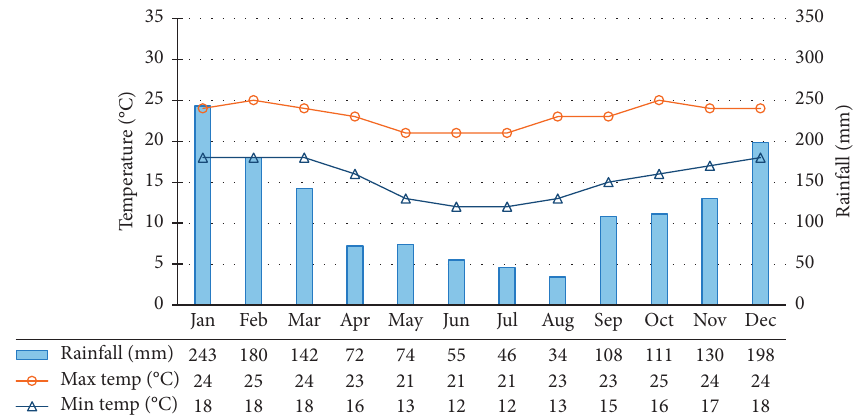
Figure 10: Annual temperature and precipitation in the trial section area: Araçariguama (source: https://www.climatempo.com.br/ climatologia/2206/aracariguama-sp).